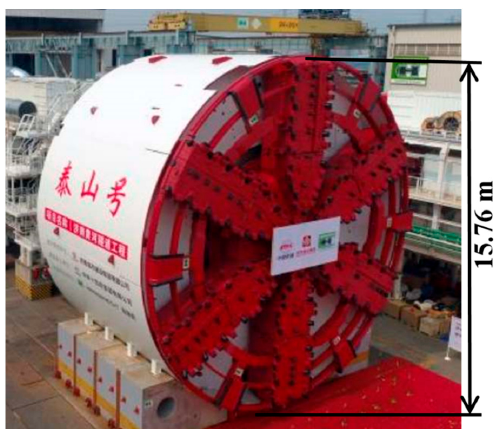
Figure 8. The used shield machine at the Jinan Huanghe River Crossing tunnel.